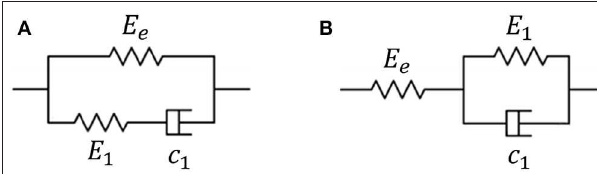
FIGURE 1 | The standard linear solid model has two forms: Maxwell form (A) and Kelvin form (B) . In this paper, the Maxwell form is used, and the term “standard linear solid model” means the Maxwell form of the standard linear solid model.